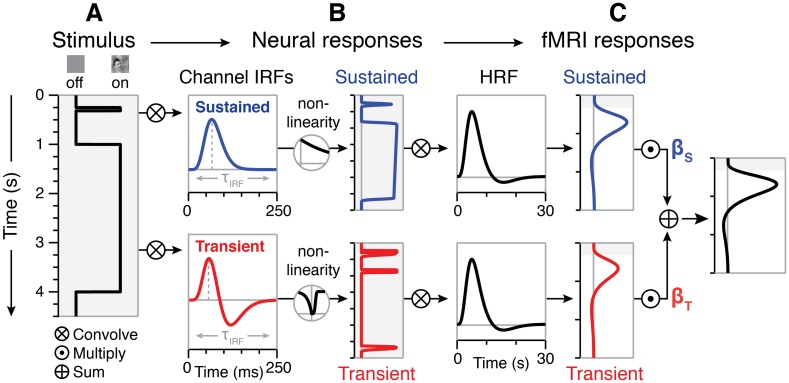
Optimized two-temporal channel A+S model with adaptation and sigmoid nonlinearities.(A) Transitions between stimulus and baseline screens are coded as a step function representing when a stimulus was on vs. off with millisecond temporal resolution. (B) Separate neural responses for the sustained (blue) and transient (red) channels are modeled by convolving the stimulus vector with an IRF for each channel. An exponential decay function is applied to the sustained channel to model response decrements related to neural adaptation, and a compressive sigmoid nonlinearity is applied to the transient channel to vary the temporal characteristics of “on” and “off” responses (Materials and methods). (C) Predictors of sustained and transient fMRI responses are generated by convolving each channel’s neural response predictors with the HRF and down-sampling to match the sampling rate of measured fMRI data. The total fMRI response is the sum of the weighted sustained and transient fMRI predictors for each channel. To optimize model parameters and estimate the contributions (β weights) of the sustained (βS) and transient (βT) channels, we fit the model to different splits of the data including runs from all three experiments.